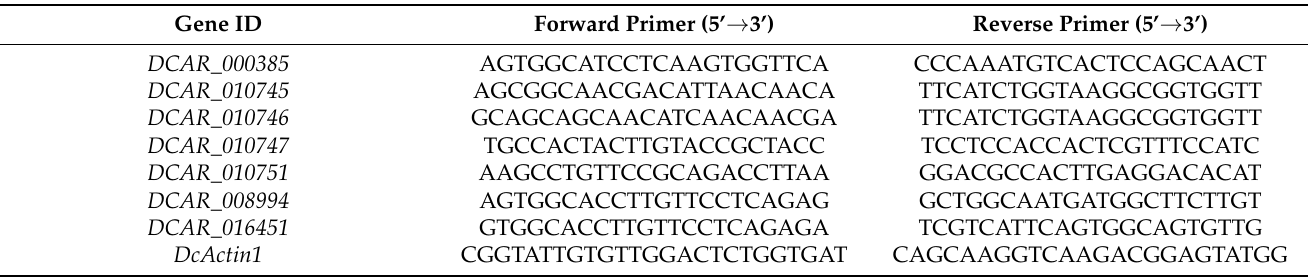
Table 1. The primer sequences used for RT-qPCR of S6 subfamily DcMYB genes. Gene